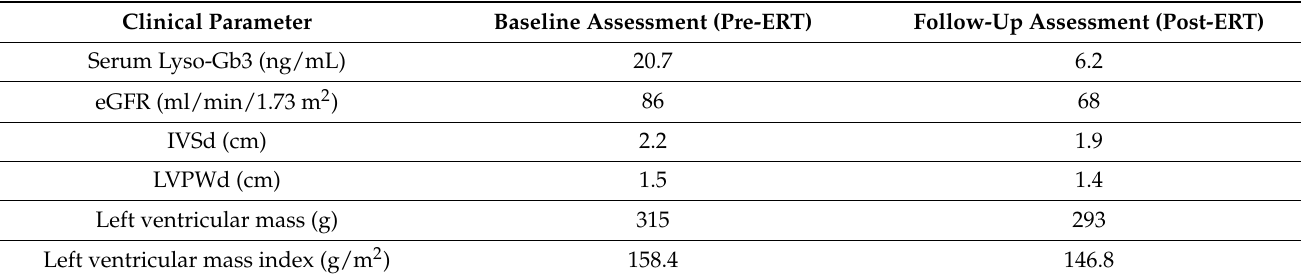
Table 3. Assessment of clinical parameters before and after a six month course of enzyme replacement therapy (ERT). Clinical